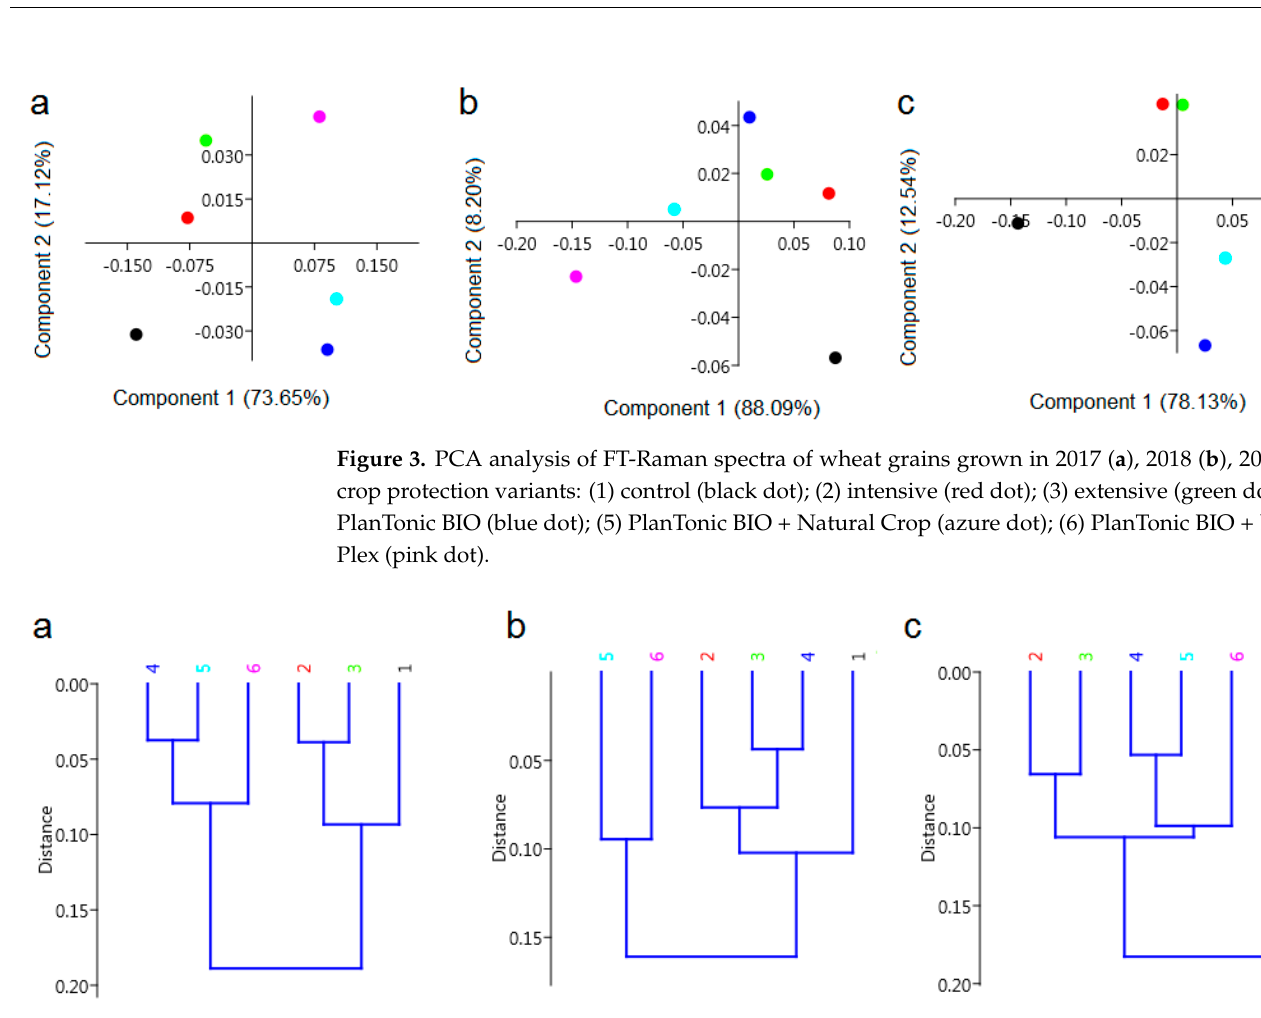
Figure 4. HCA analysis of FT-Raman spectra of wheat grains grown in 2017 ( a ), 2018 ( b ), 2019 ( c ); crop protection variants: control (1); intensive (2); extensive (3); Plantonic (4); Plantomic + Natural Crop (5); Plantonic + Biofol Plex